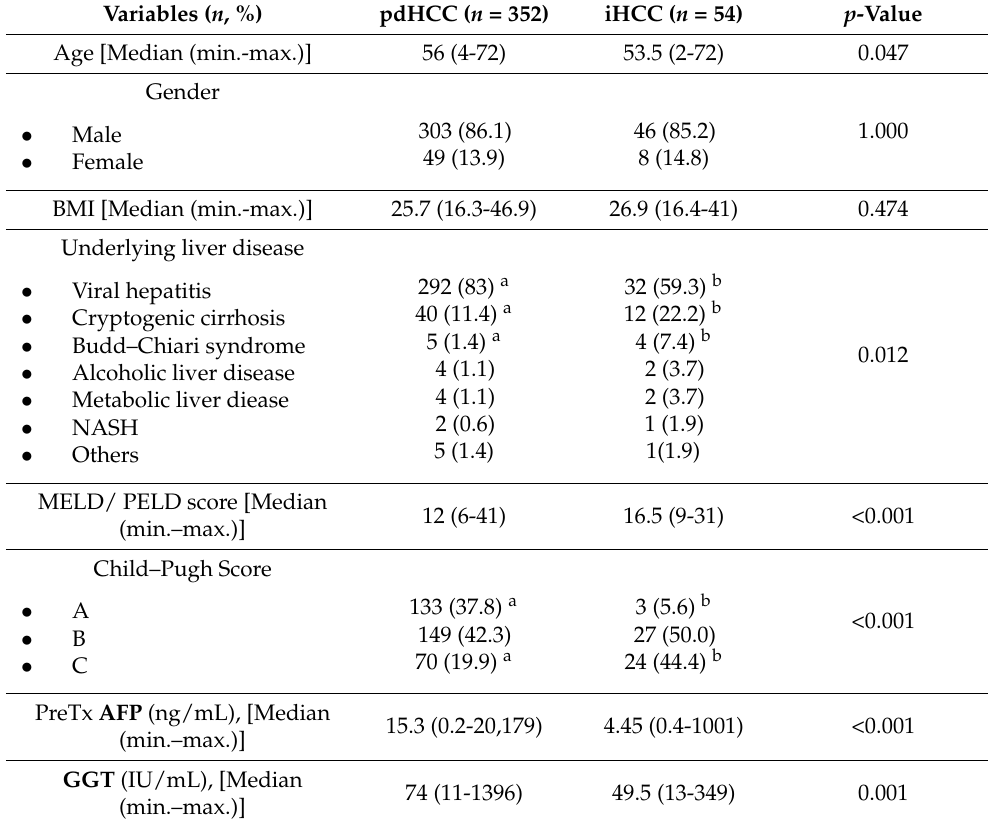
Table 1. Clinical characteristics and demographic features of pdHCC and iHCC. Variables ( n , %) pdHCC ( n = 352) iHCC ( n = 54) p